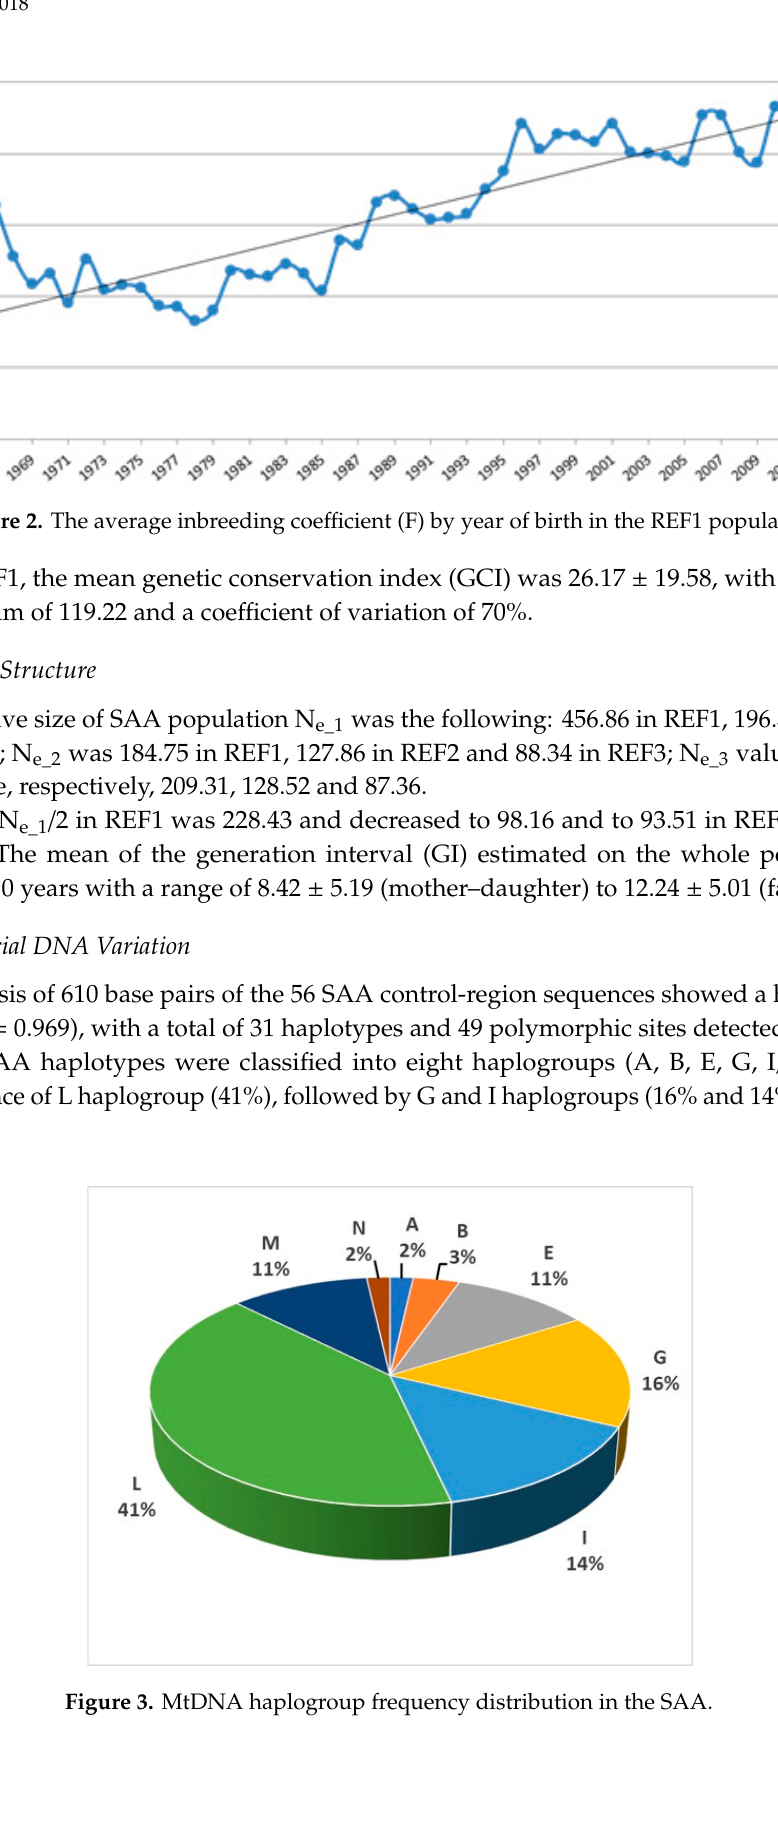
Figure 2. The average inbreeding coefficient (F) by year of birth in the REF1 population.